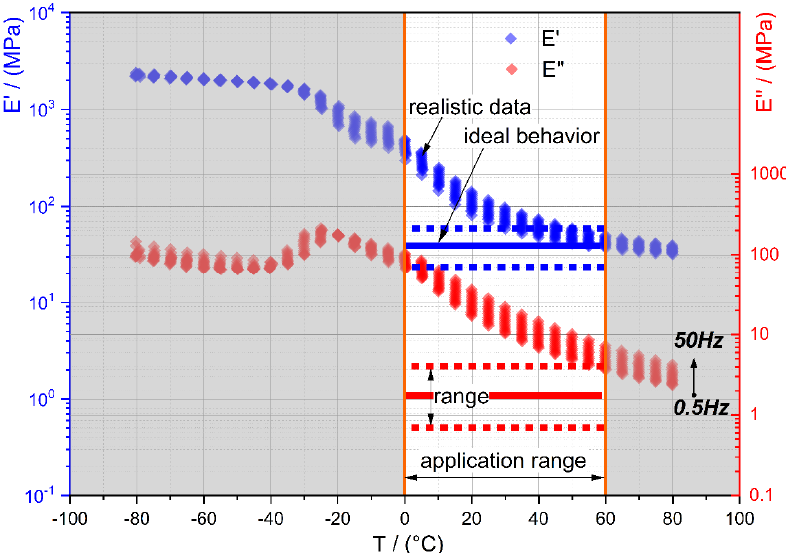
Figure 13. Illustration of the realistic material behaviour and the idealistic material behaviour for the soft layer of the wobbling